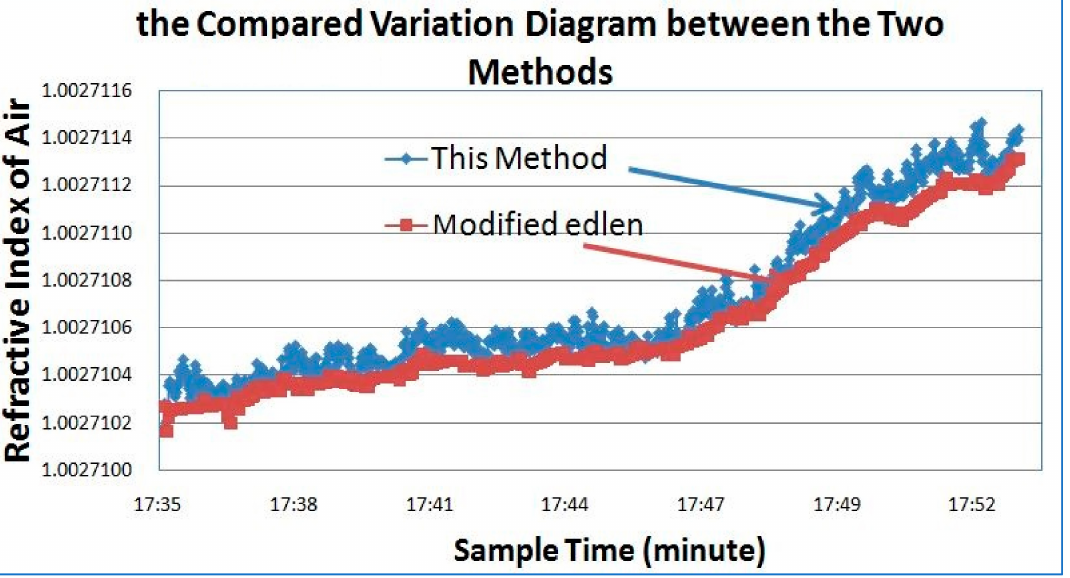
Figure 5. The compared variation diagram between the two methods.